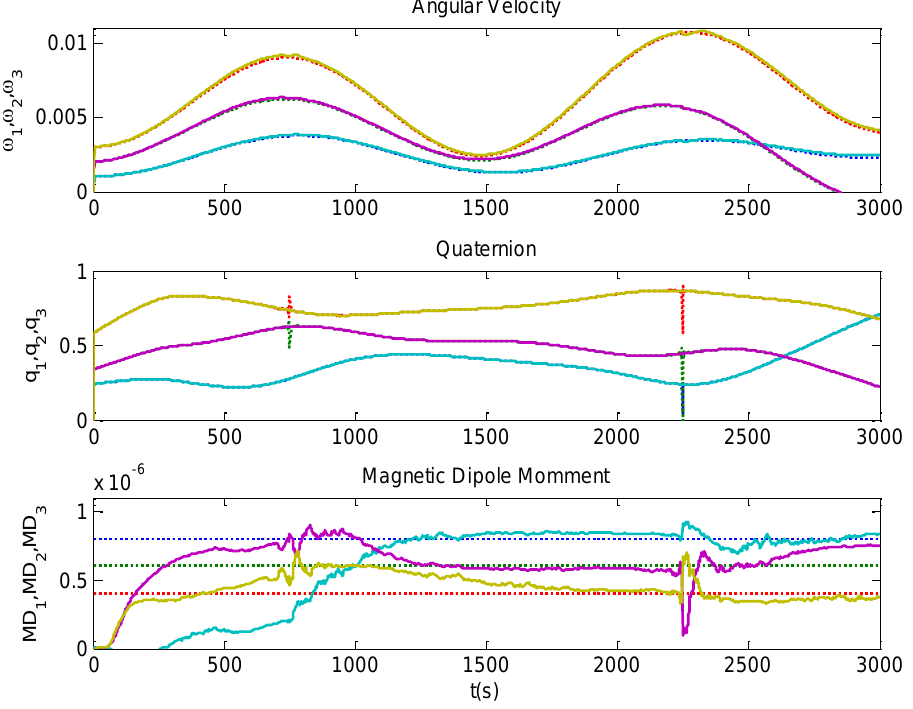
Figure 12. NS-1B attitude estimation (solid line) using Kalman filter including dipole moment estimation. It can be noticed that there are some MDM observability problems, causing divergences in some time intervals.